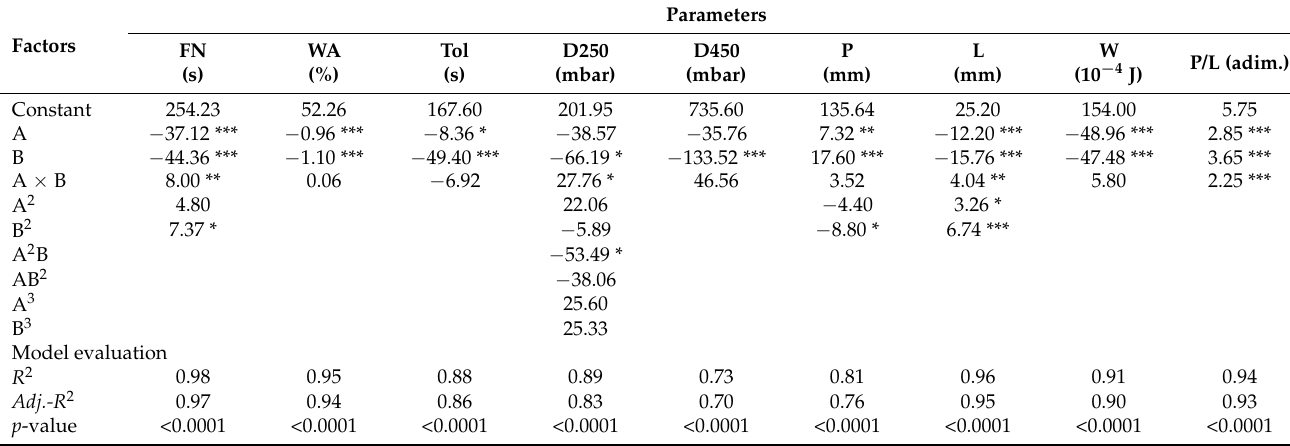
Table 2. ANOVA results of the models fitted for falling number and dough rheological properties (consistograph and alveograph